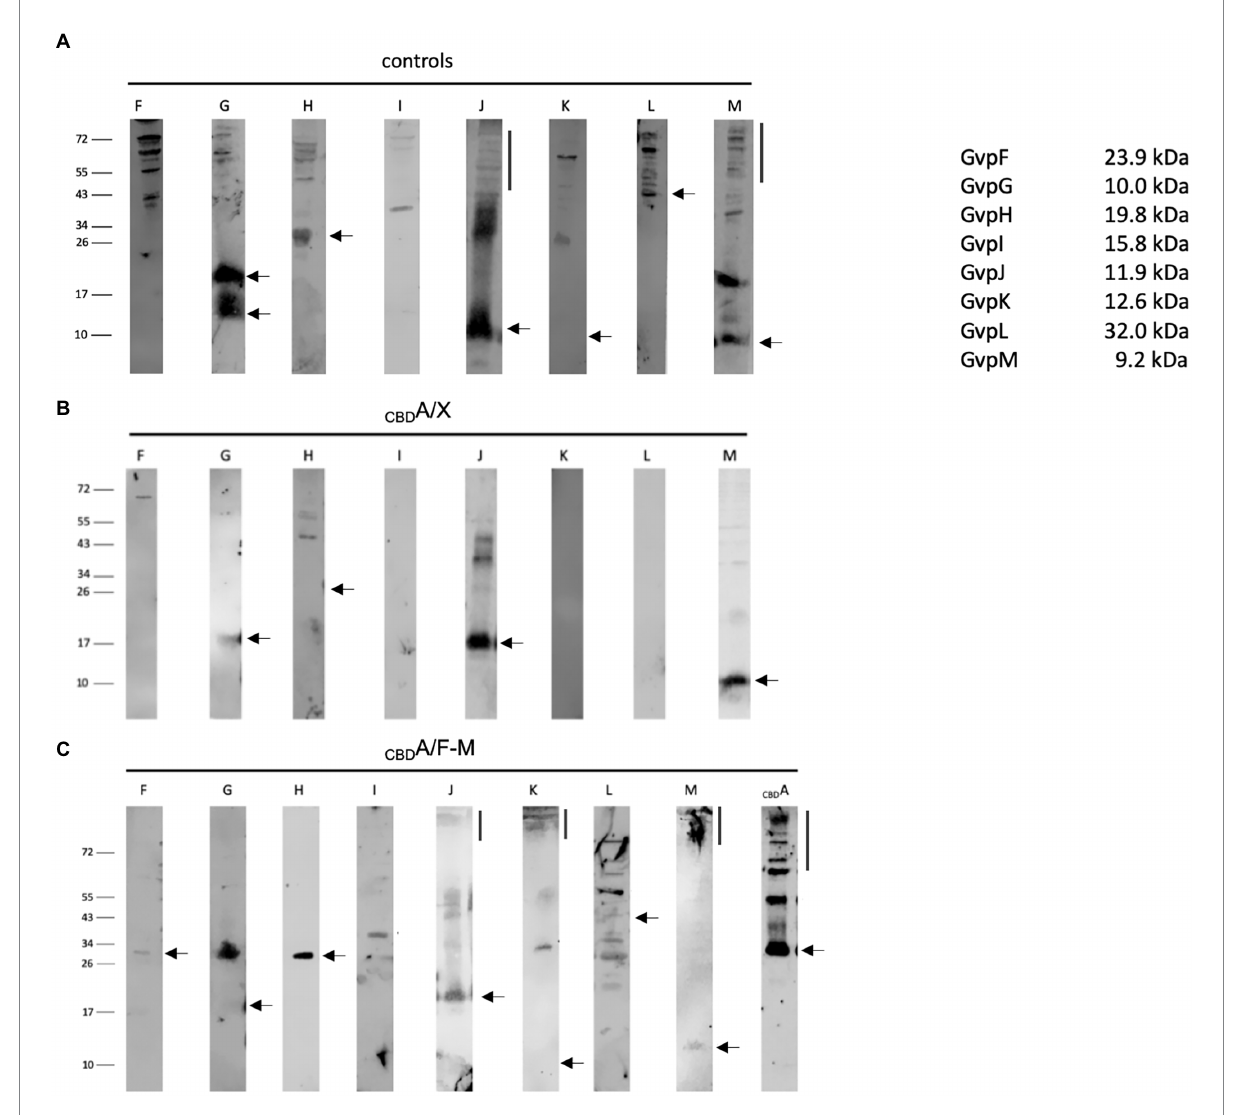
FIGURE 7 Western analyses of the pulldown assays using CBD A as bait and GvpF through GvpM as single proteins or altogether as prey. In each case, 15 μ l of the elution sample was separated by SDS-PAGE, and the proteins were transferred to a PVDF membrane that was incubated with the respective antiserum. The proteins were visualized by the fluorophore-labeled secondary antibody IRDye 800 CW (Licor). The blots are inverted to black– white. Numbers on the left indicate sizes in kDa. (A) Western analysis of Hfx. volcanii producing the GvpF, G, H, I, J, K, L, or M protein used as control. The respective Gvp proteins are marked on top. (B) Results of the CBD A/X interactions (X = F, G, H, I, J, K, L, or M). The single Gvp protein used as prey is indicated on top. Only the elution fraction is shown. (C) Results on the CBD A/F-M interaction where GvpF through GvpM proteins is produced together in the same cell. Only the elution fraction is shown. The antiserum used to detect one of these Gvp proteins is indicated on